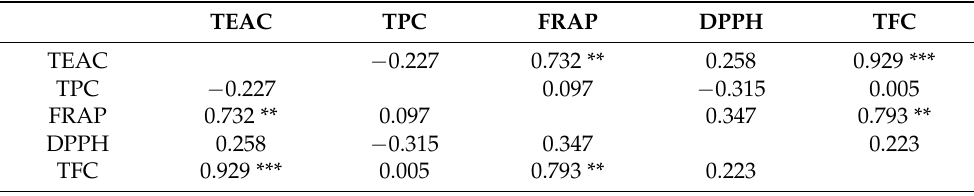
Computed correlation used Pearson-method.